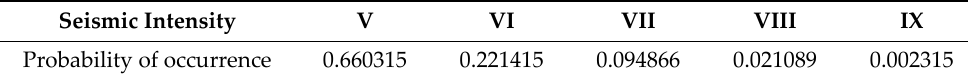
Table 5. Probability of occurrence of earthquakes of different intensities.